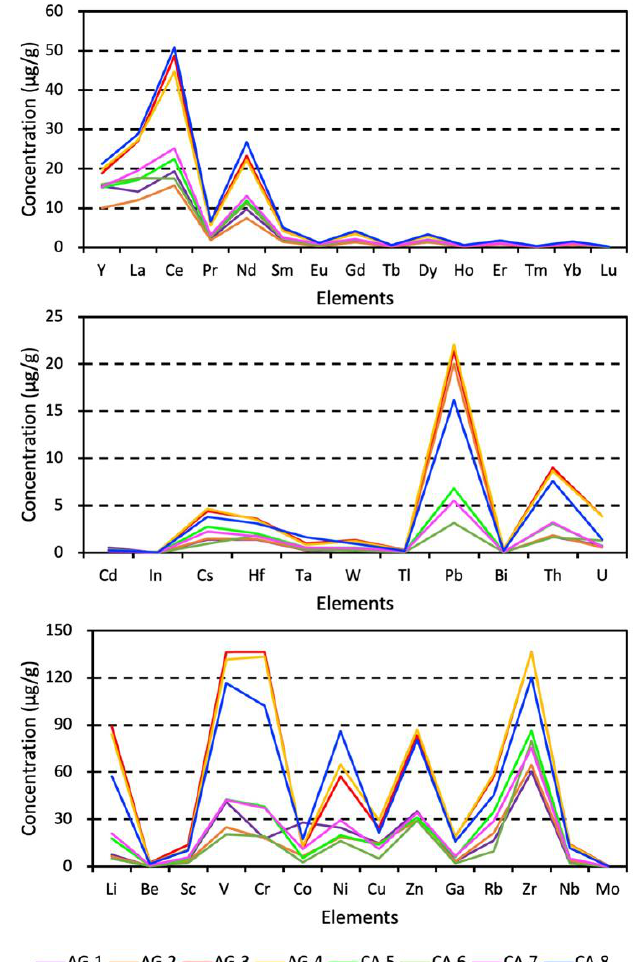
Figure 3. Element analyses by ICP-MS for the samples collected from Agost and Caravaca, Spain.